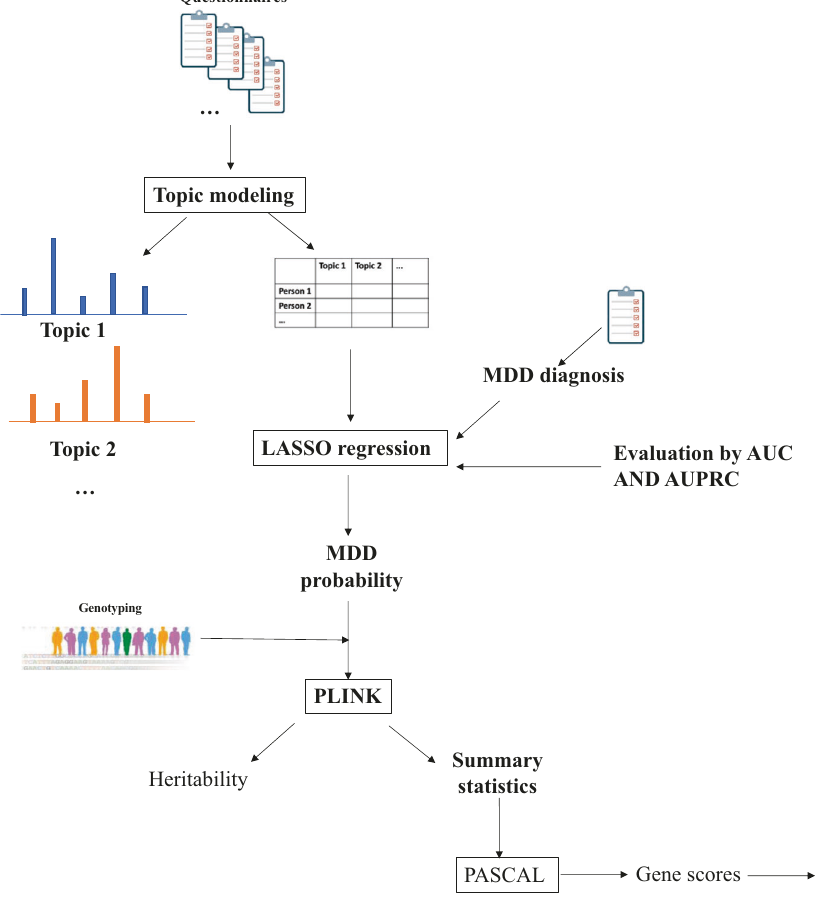
Fig. 1 Schematic pipeline of the preprocessing and statistical analysis performed in this